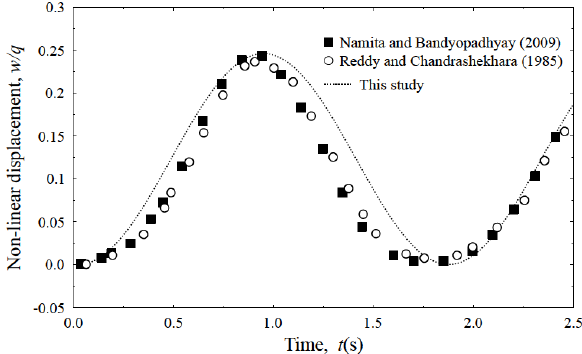
Figure 2: Non-dimensionalized nonlinear transient displacement ( w / q ) of composite spherical shells under uniformly distributed load ([0/90], Material